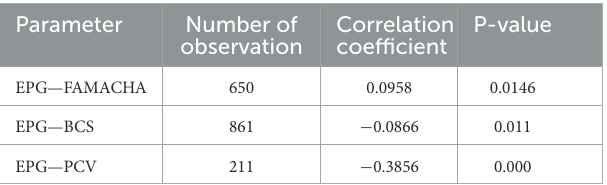
TABLE 9 Correlation among EPG, FAMACHA scores, BCS, and PCV. Parameter Number of Correlation observation